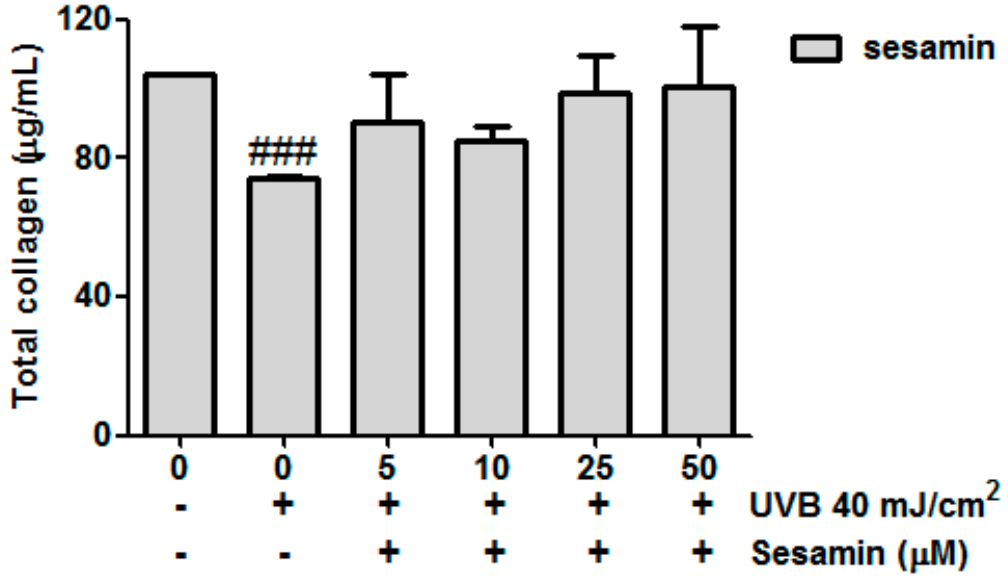
Figure 8. E ff ect of sesamin on the total collagen biosynthesis in human skin fibroblasts. ### p < 0.001: Significant di ff erence versus non-irradiation group.